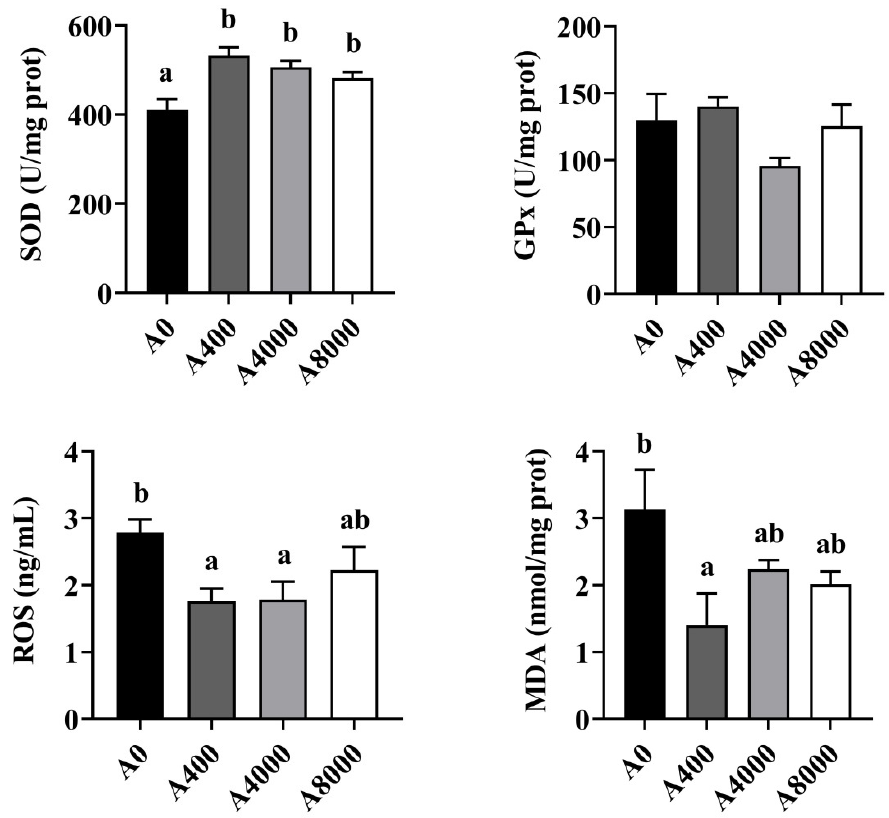
Figure 4. Effects of dietary AMP on activities of antioxidant enzymes in the liver ( n = 6). SOD: superoxide dismutase; GPx: Glutathione peroxidase; ROS: Reactive oxygen species; MDA: Malondialdehyde. Data are shown as mean ± SEM ( n = 6). Different lowercase letters represent significant differences among all groups ( p < 0.05).